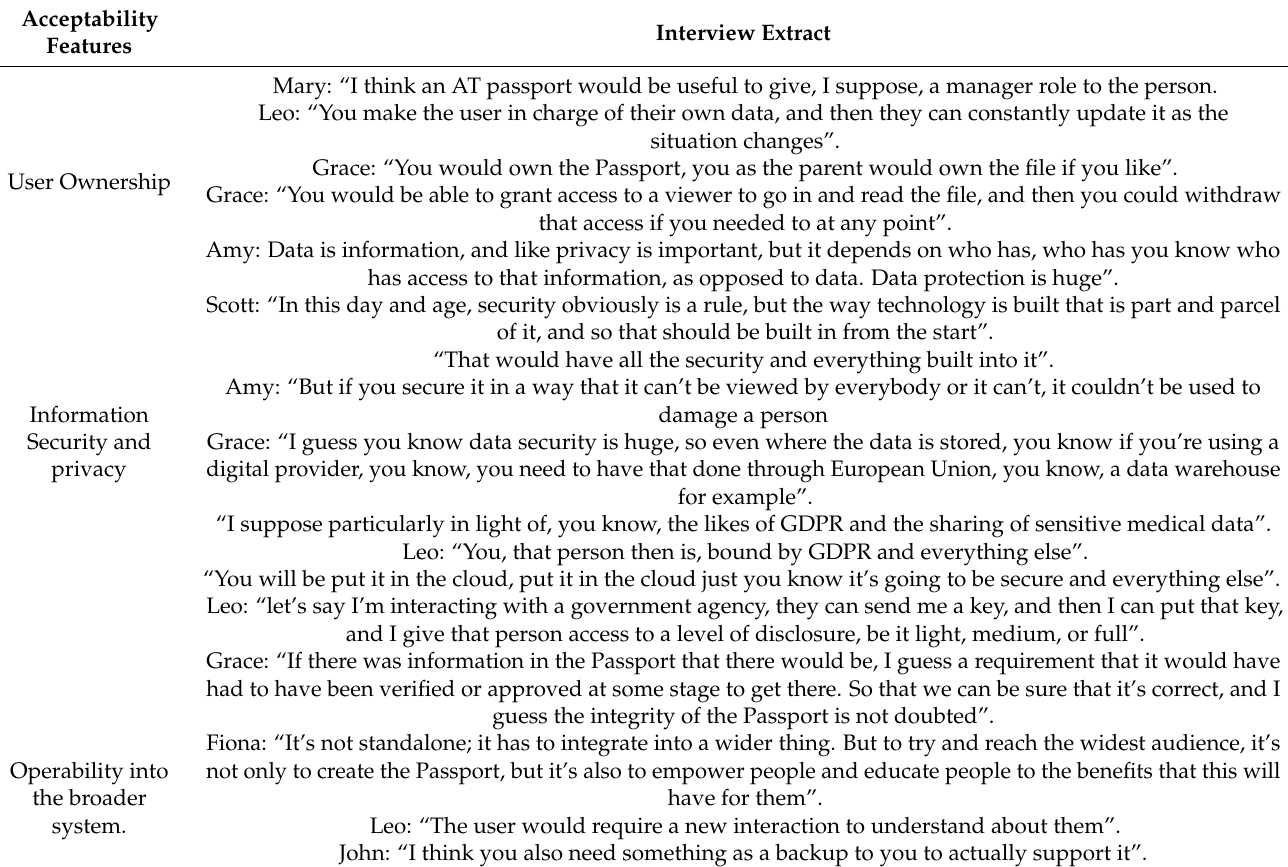
Table 5. AT Passport proposed Acceptability